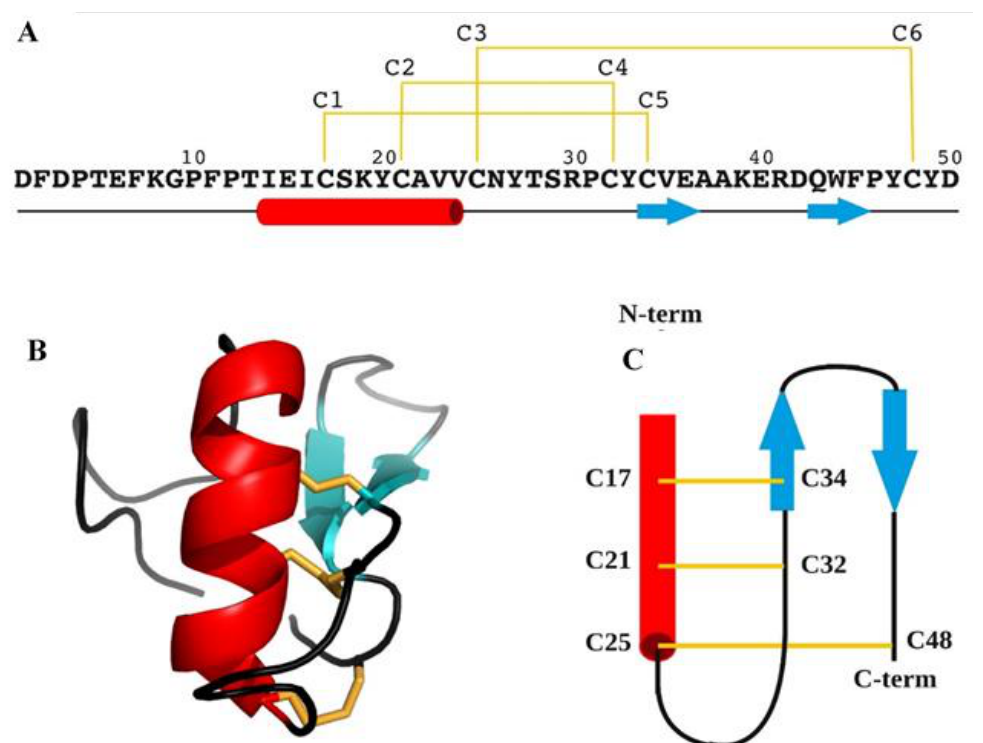
Figure 6. ( A ) Primary structure of BCR4 peptide. ( B ) Three-dimensional structure of BCR4. ( C ) Topology diagram of BCR4. α -helix, β -sheet, and random coil are represented in red, cyan and black, respectively. Disulfide bonds are colored in yellow.